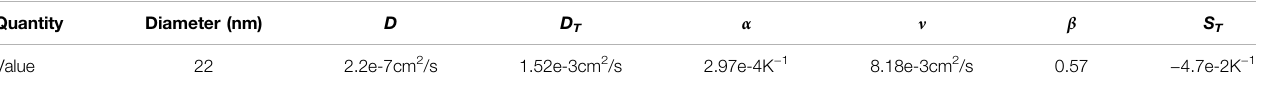
TABLE 1 | LUDOX TM TMA thermo-physical properties.